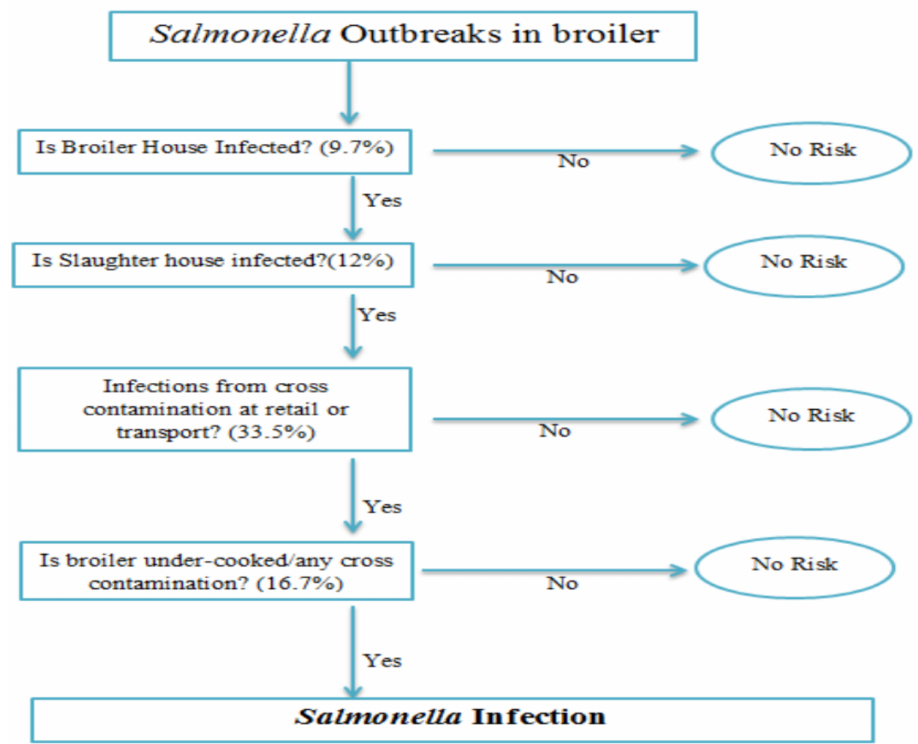
Figure 1. Probability framework of Salmonella infections at different nodes using the farm-to-fork